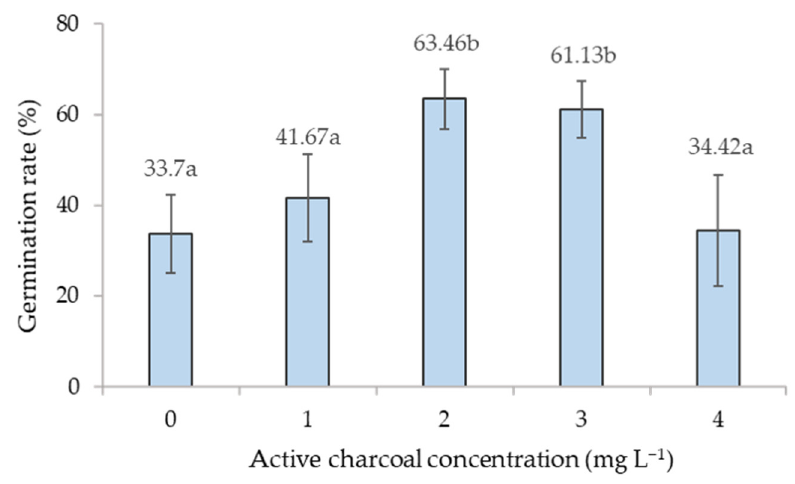
Figure 6. Effects of active charcoal on somatic embryo